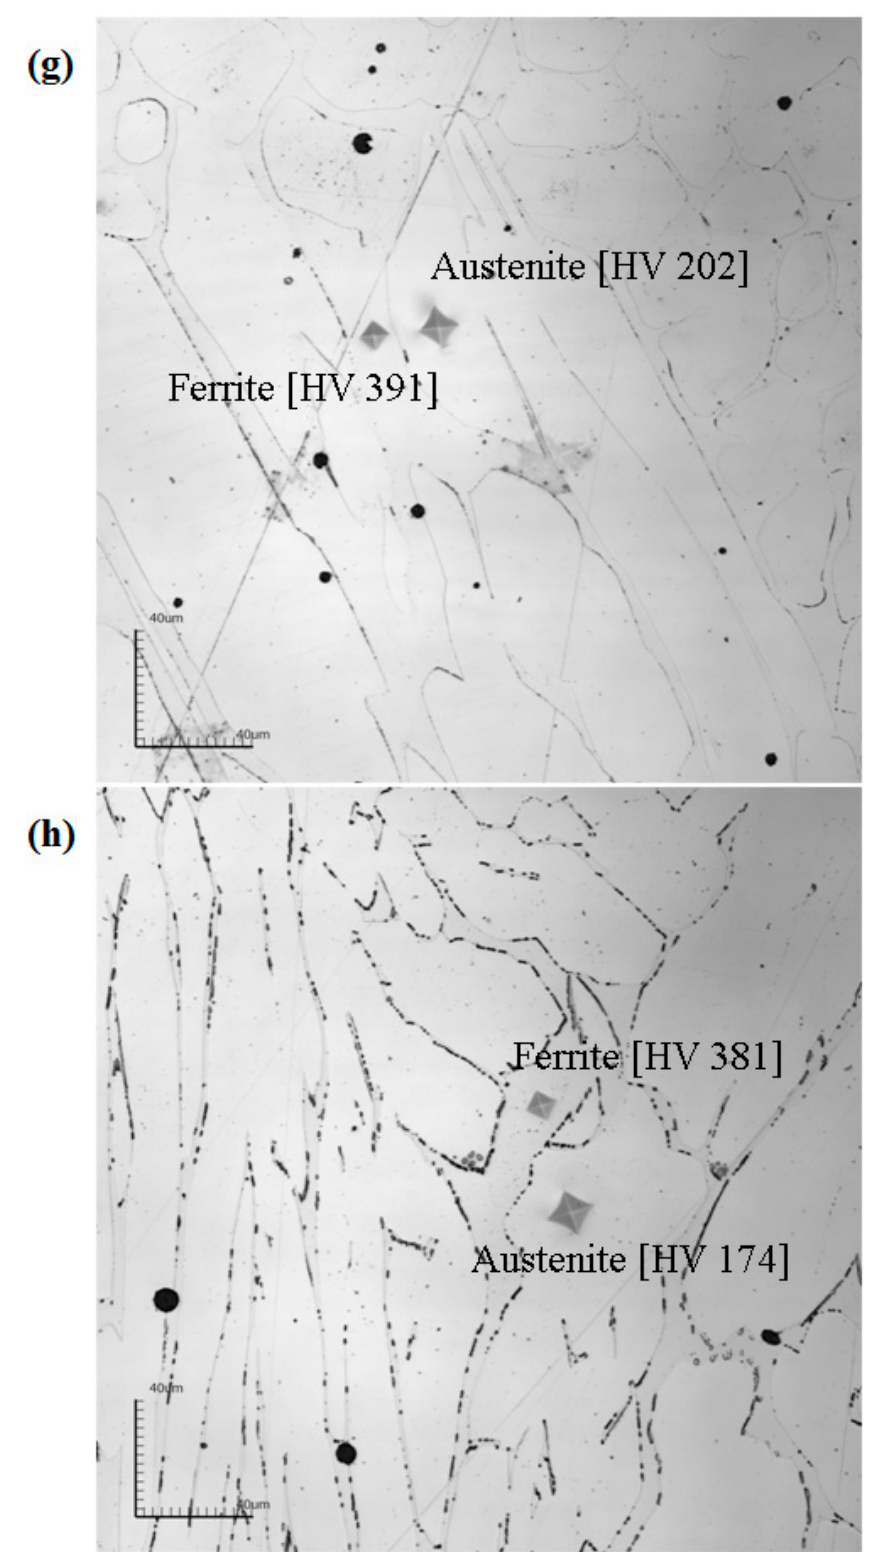
Figure 7. Microstructure and hardness test indentations of specimens age-treated at 385 ◦ C for various periods of time, ( a ) LF 0 h; ( b ) LF 2400 h; ( c ) LF 6000 h; ( d ) LF 30,000 h; ( e ) HF 0 h; ( f ) HF 2400 h; ( g ) HF 6000 h; ( h ) HF 30,000